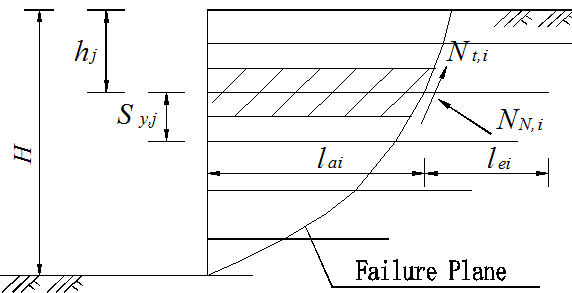
Figure 1. Illustration of failure mechanism of reinforced wall by the horizontal slice method (HSM) (modified after Jia et al. 2018).